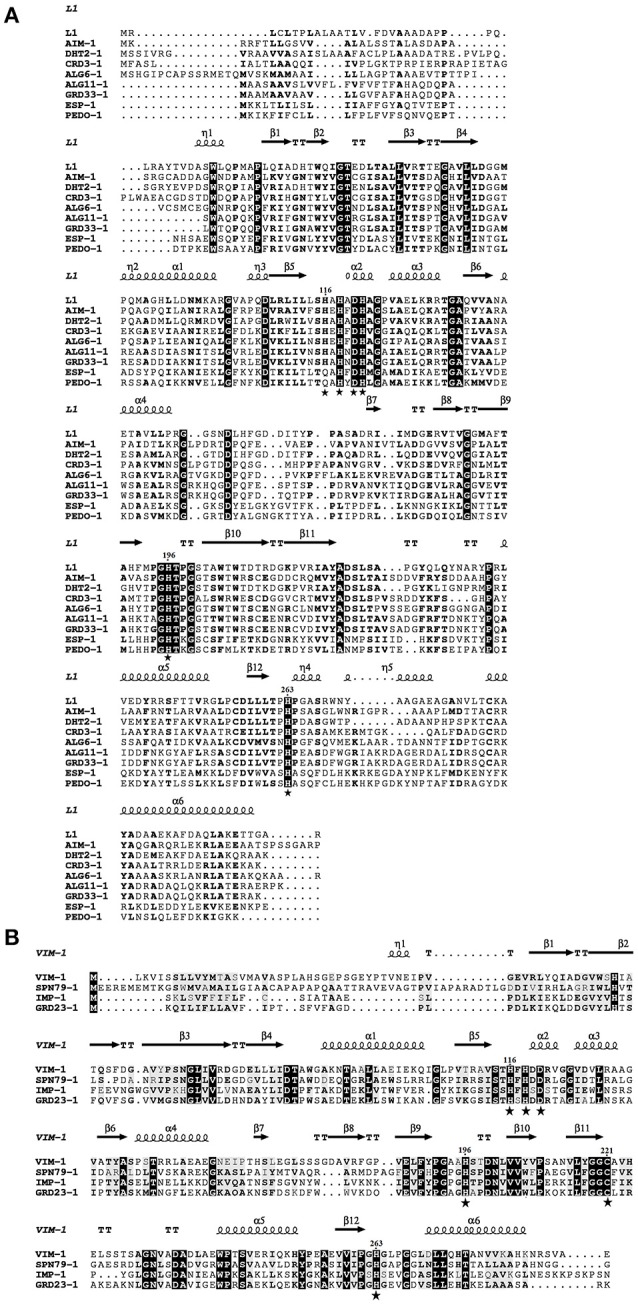
Amino acid alignment of the new subclass B3 (A) and B1 (B) metallo-ß-lactamases (MBLs) detected in this study with known MBLs whose 3-D structure has been resolved by X-ray crystallography. Zinc-binding amino acids are indicated by a star.